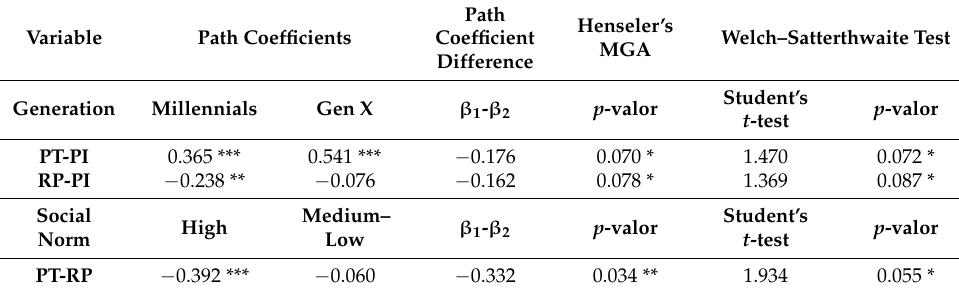
Table 6. Multi-group analysis by generation and social